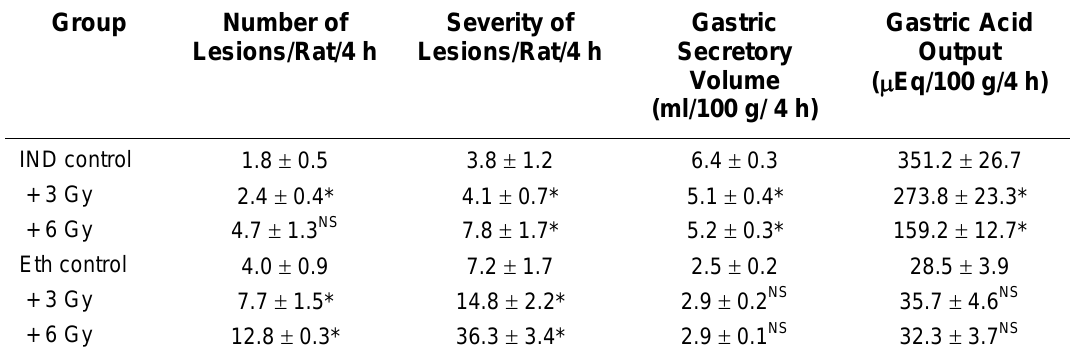
Effect of a Single Dose (3 or 6 Gy) Whole-Body Gamma Irradiation on the Indomethacin- and Ethanol-Induced Gastric Mucosal Damage in 4-h Pylorus-Ligated Rats Group Number of Severity of Lesions/Rat/4 h Lesions/Rat/4 h